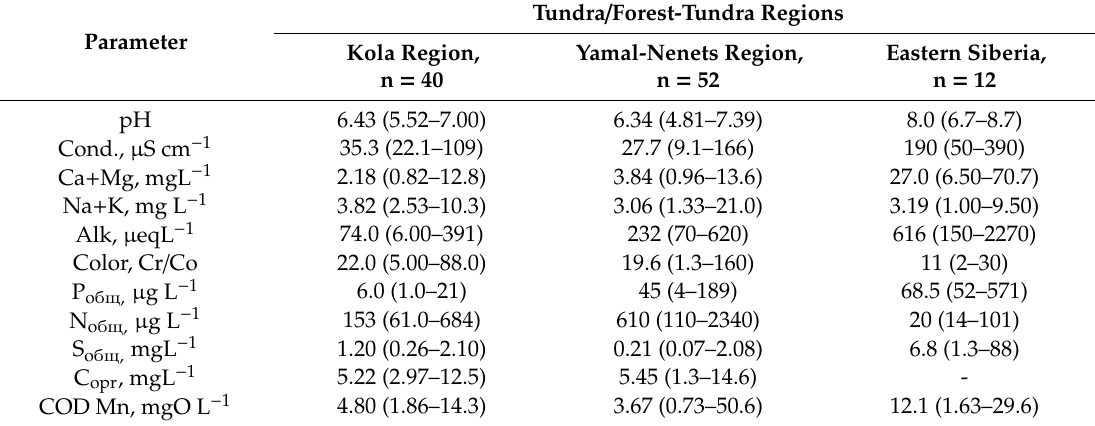
Table 1. Median and variability of the general chemical parameters (min–max) in the water of lakes in the Arctic regions: the European part of Russia (ER, Kola region), Western Siberia (WS, Yamal-Nenets region) and Eastern Siberia (ES, Norilsk region). Tundra / Forest-Tundra Regions Parameter Kola